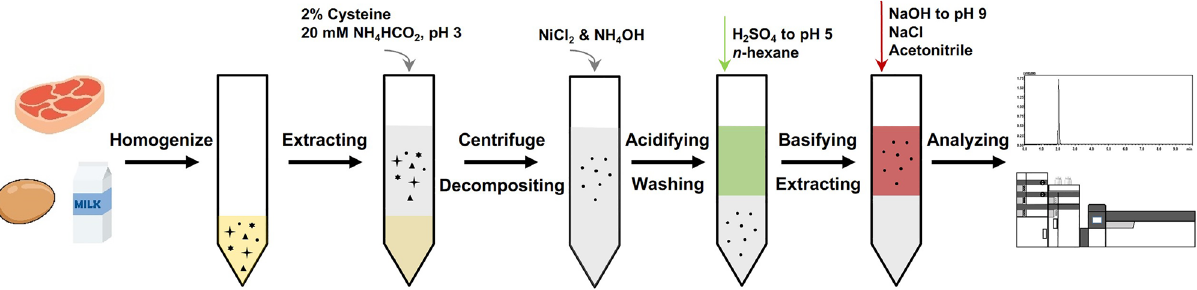
Figure 5. Schematic procedure of the developed method for nereistoxin insecticides in animal-derived